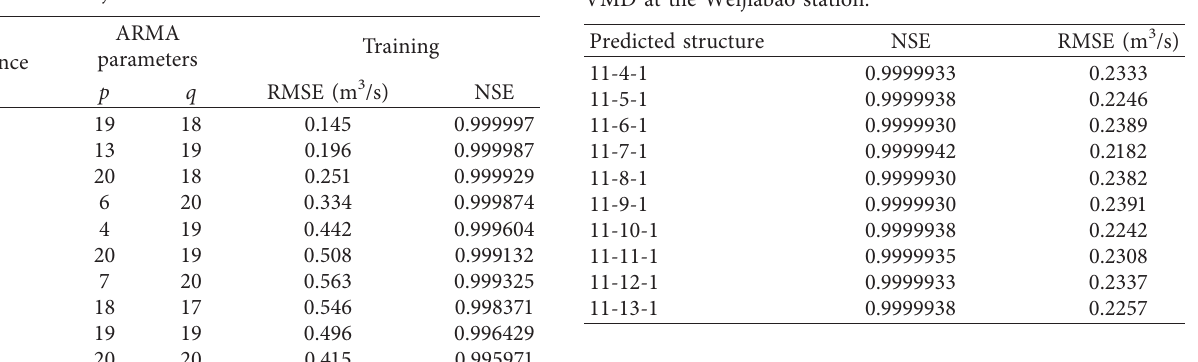
Table 4: Performance of the ARMA model during the training period at the Weijiabao station.